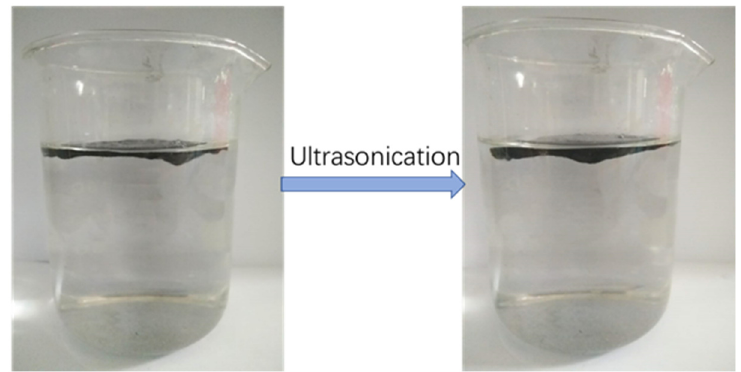
Figure 11. The stability comparison of RGM which are sonicated for 30 min.